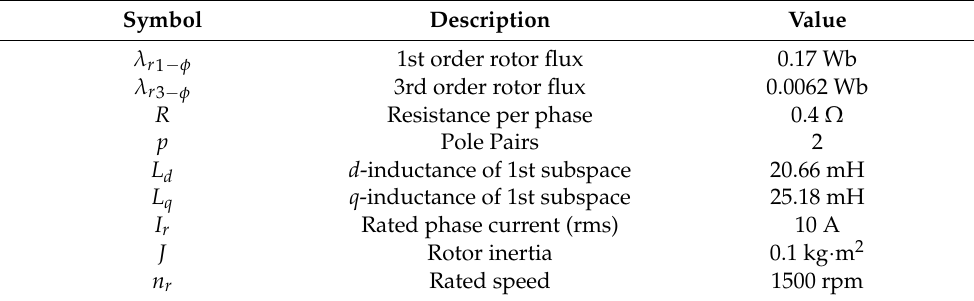
Table 1. Prototype motor